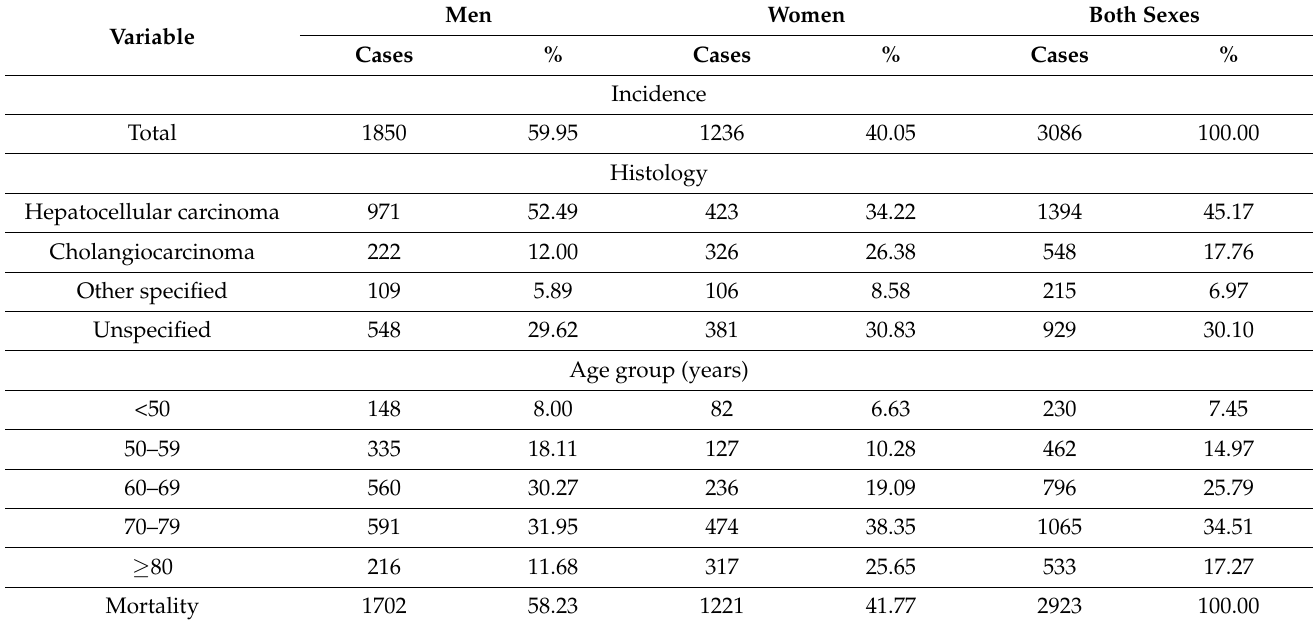
Table 1. Characteristics of the primary liver cancer patients included in the